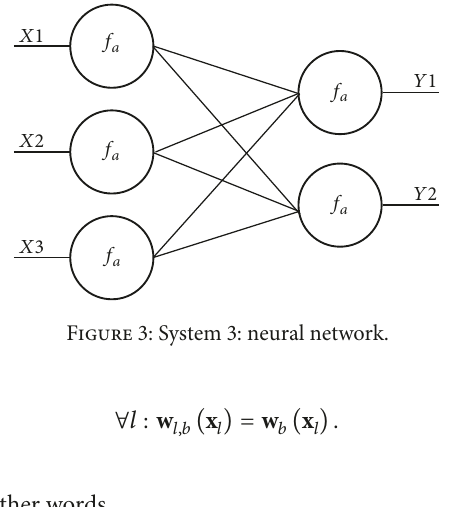
Figure 3: System 3: neural